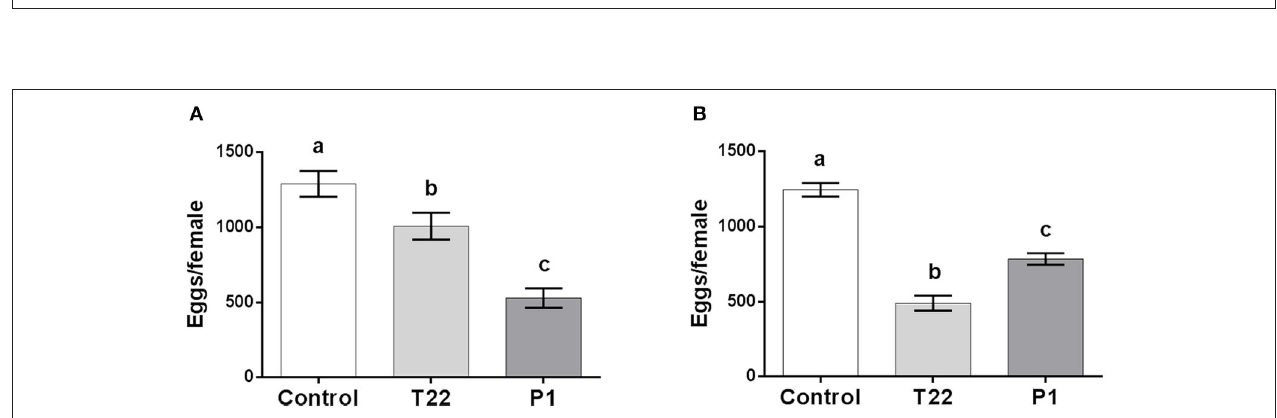
FIGURE 5 | Spodoptera littoralis fertility. Adults emerging from larvae fed on T22- and P1-tomato leaf showed lower fertility compared to adults. At 20 ◦ C, (A) the lower performance was observed on P1-tomato, whereas at 25 ◦ C, (B) fertility was significantly poorer on T22-tomato. The values are means ± SD. Mean values denoted with different letters are significantly different (one-way ANOVA test, P < 0.0001).